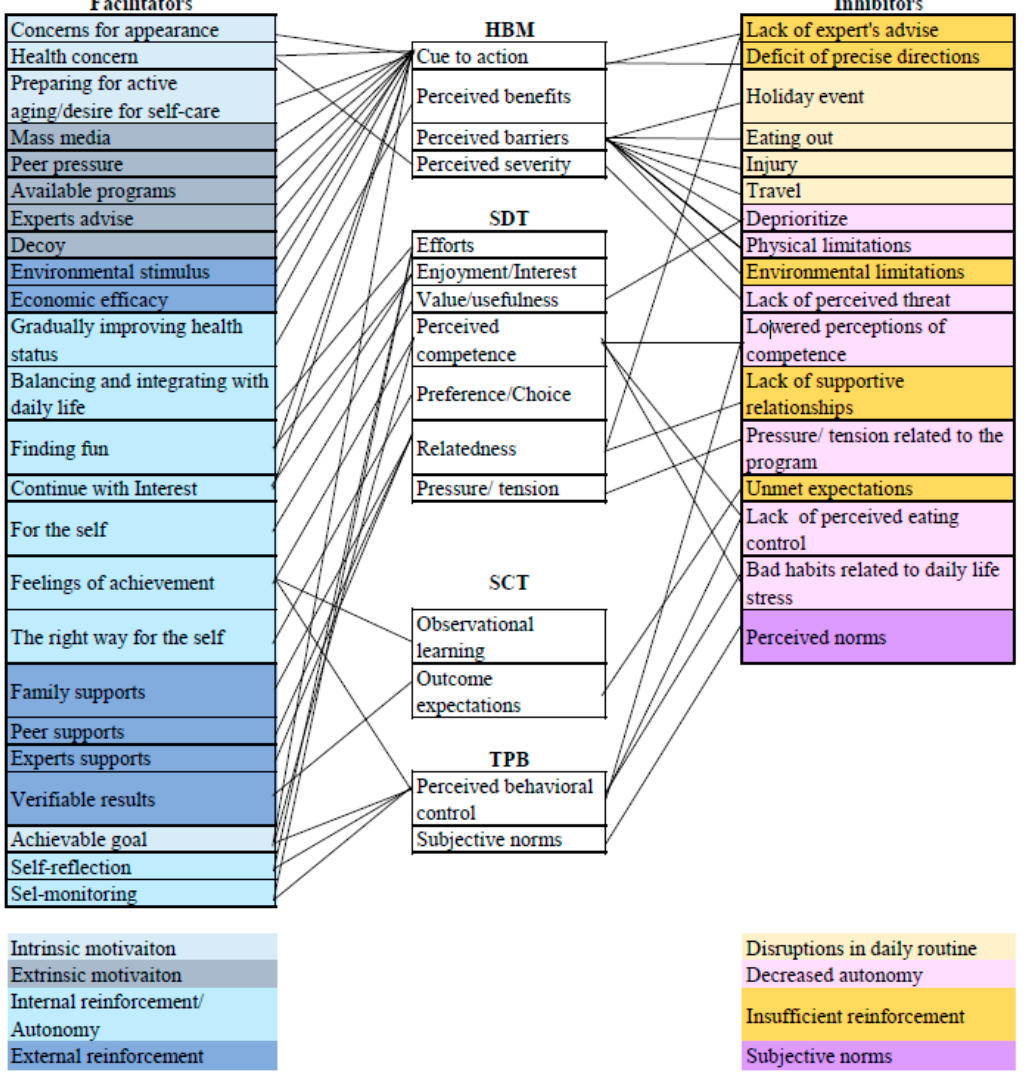
Figure 1. Theory guided mapping. HBM: health belief model; SDT: Self-determination theory; SCT: Social cognitive theory; TPB: Theory of planned behavoir.